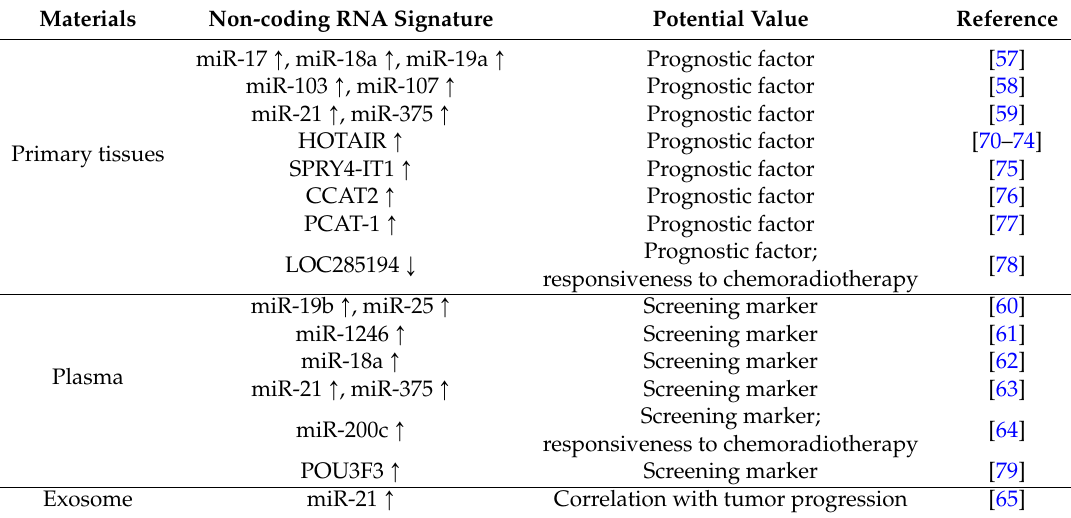
Table 1. Potential biomarkers in